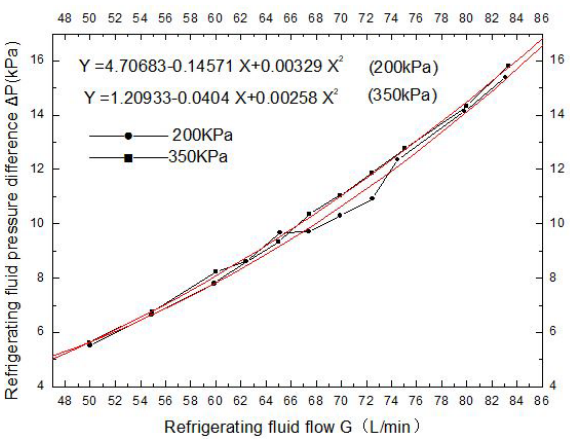
Figure 8. Variation of pressure drop with flow rate (temperature 60 C ° ).